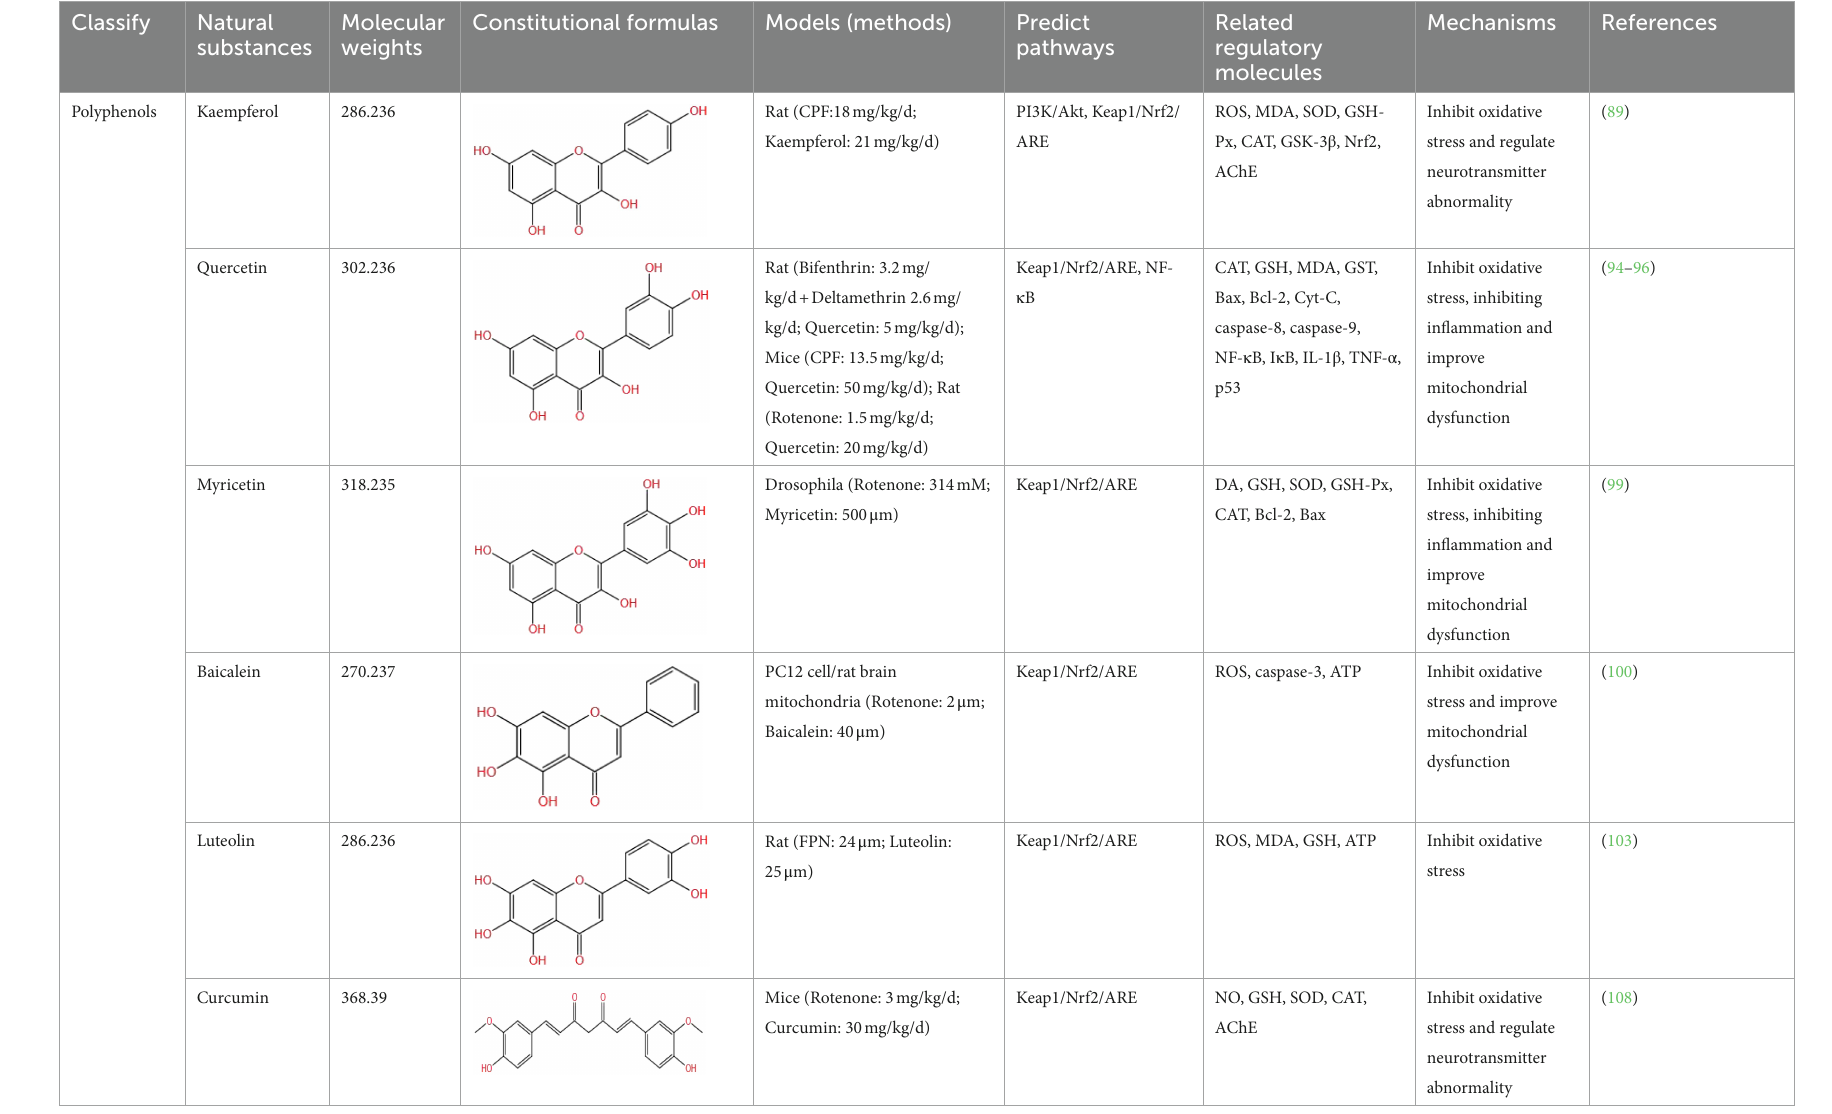
TABLE 1 Effects and characteristics of natural substances on pesticide-induced cognitive impairment.